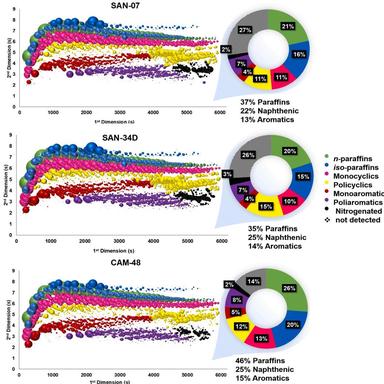
Reconstructed chromatograms containing identified classes and class distribution obtained by GC × GC-FID.